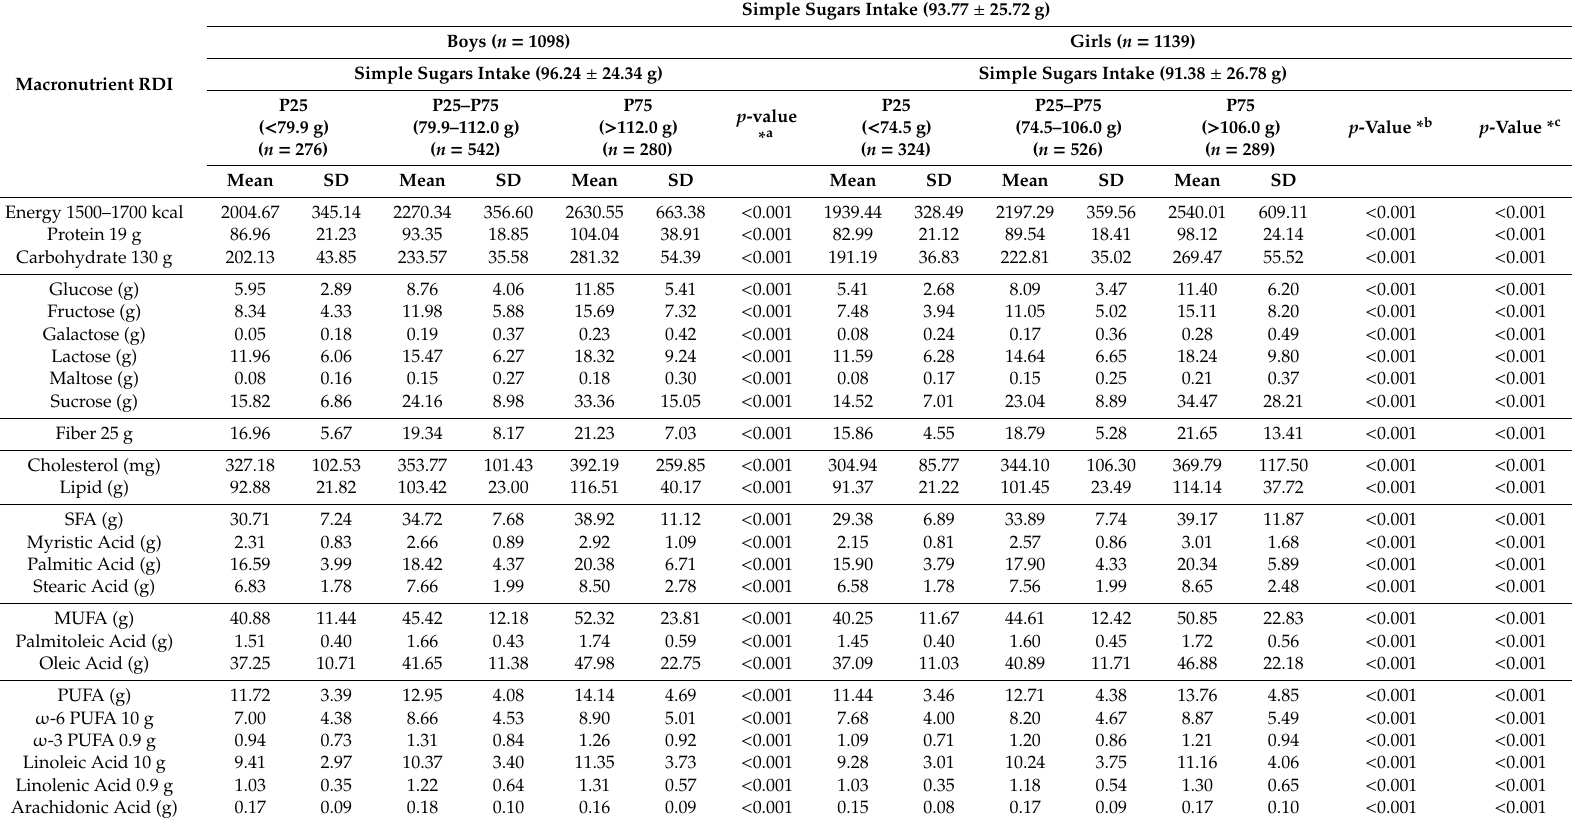
Table 8. Macronutrients intake consumed by 6–8-years old children ( n = 2237) in Valencia, Spain,